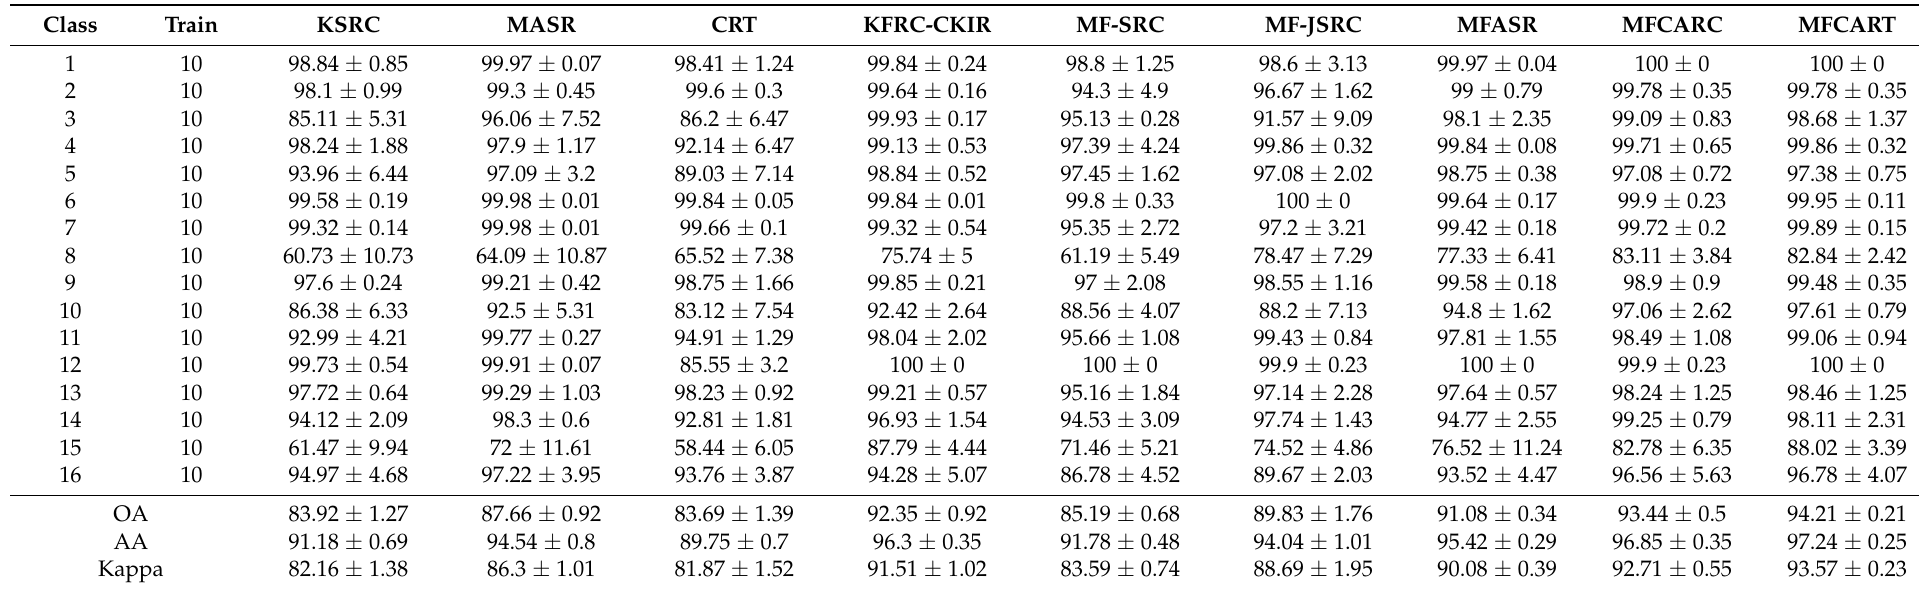
Table 9. Classification accuracy (%) of different classifiers for the Salinas data